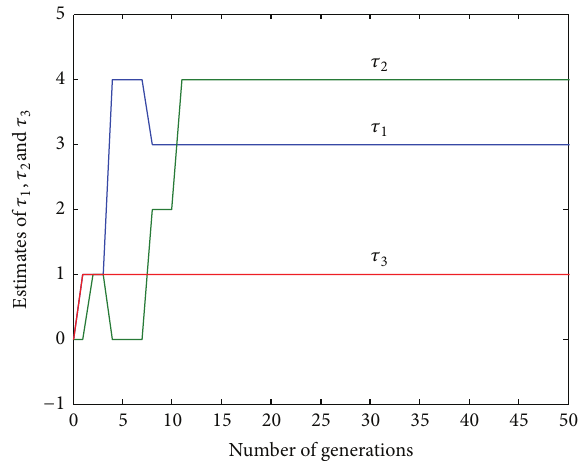
Figure 3: Estimates of 𝜏 1 , 𝜏 2 , and 𝜏 3 for Run 1 of Example 2.